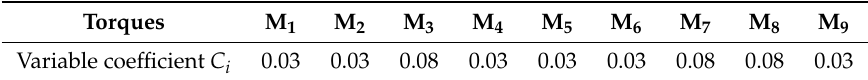
Table 3. Variable coe ffi cients of nine torque.